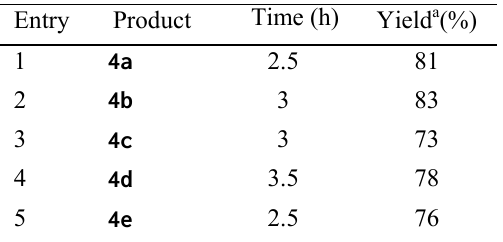
Table 2. One-pot synthesis of